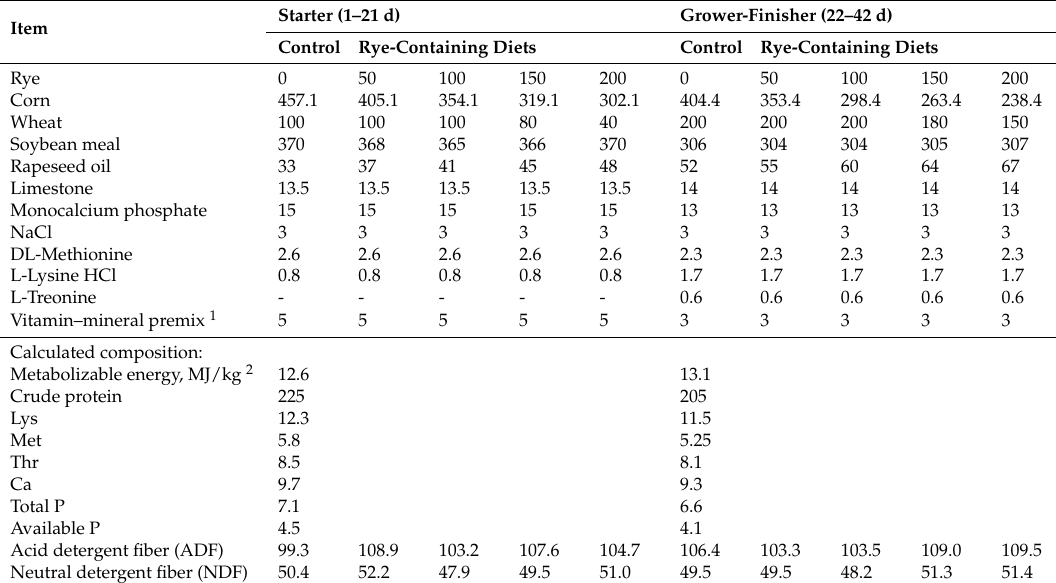
Table 1. Composition and nutrient content of experimental diets, g/kg air dry matter.